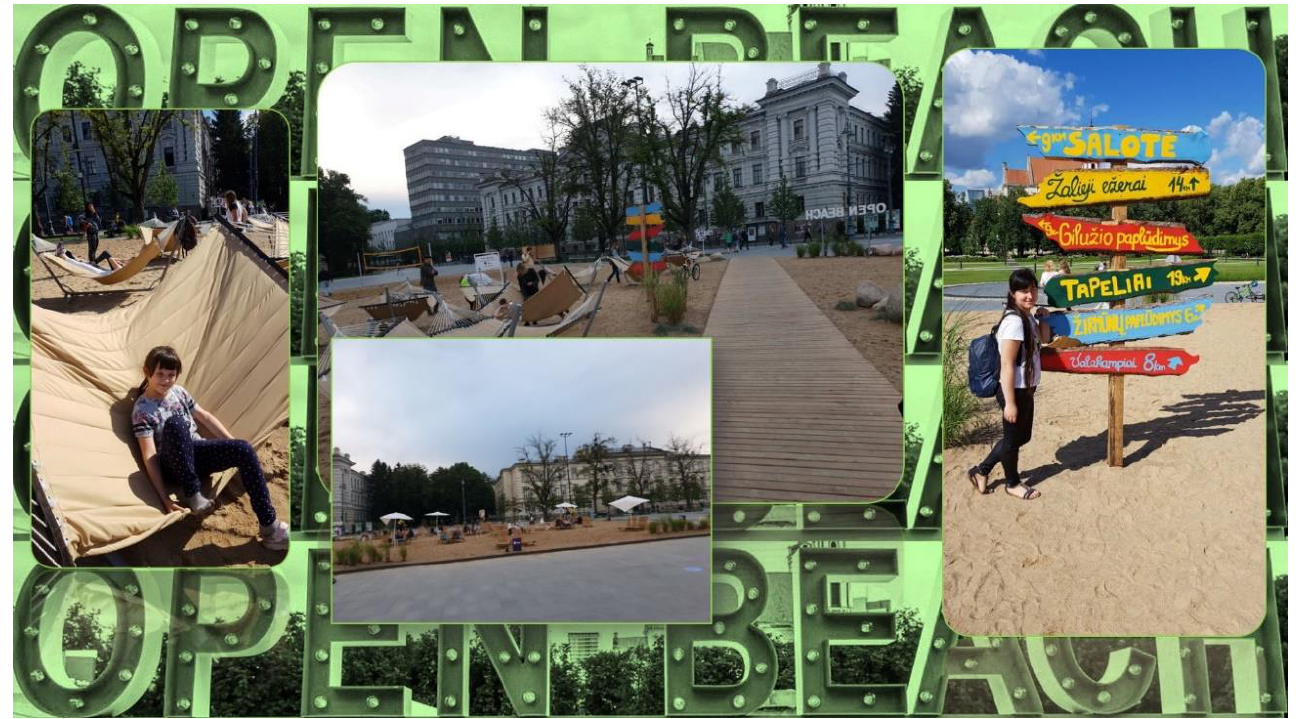
Figure 2. Photo collage of the Vilnius Pop-up Beach ( Photo collage made by the authors ) .